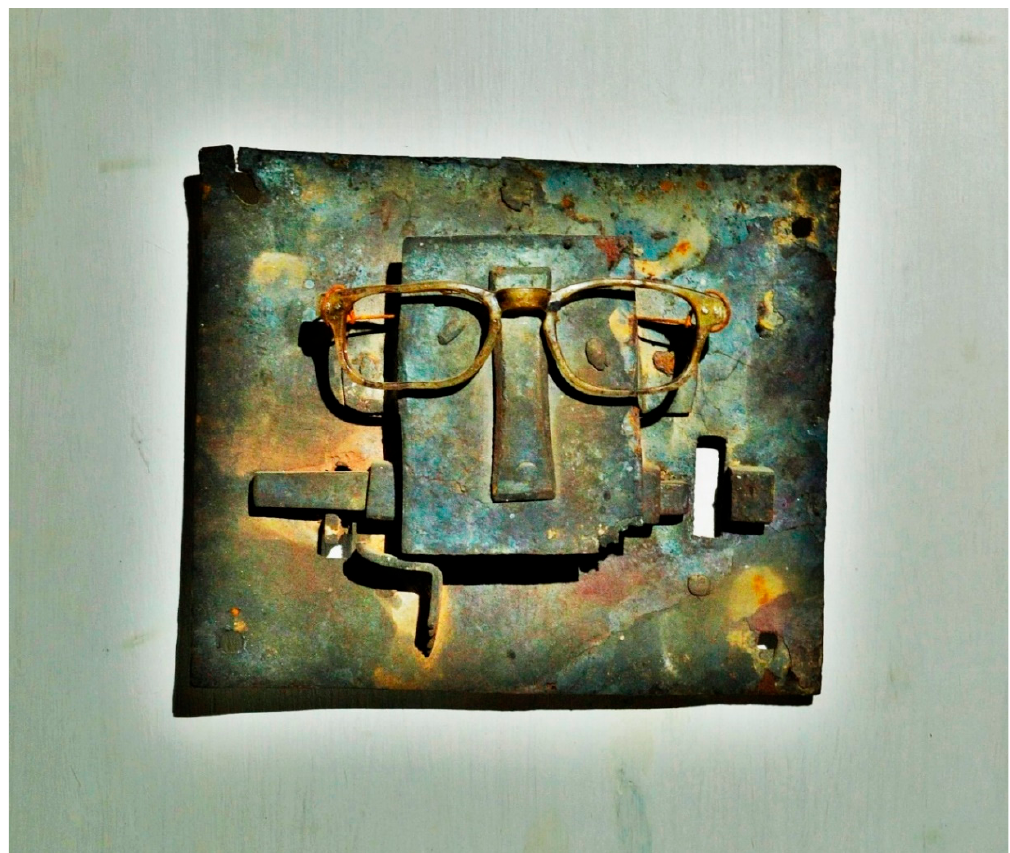
Figure 6. Man with Glasses. Photo by Agricubismo ® .